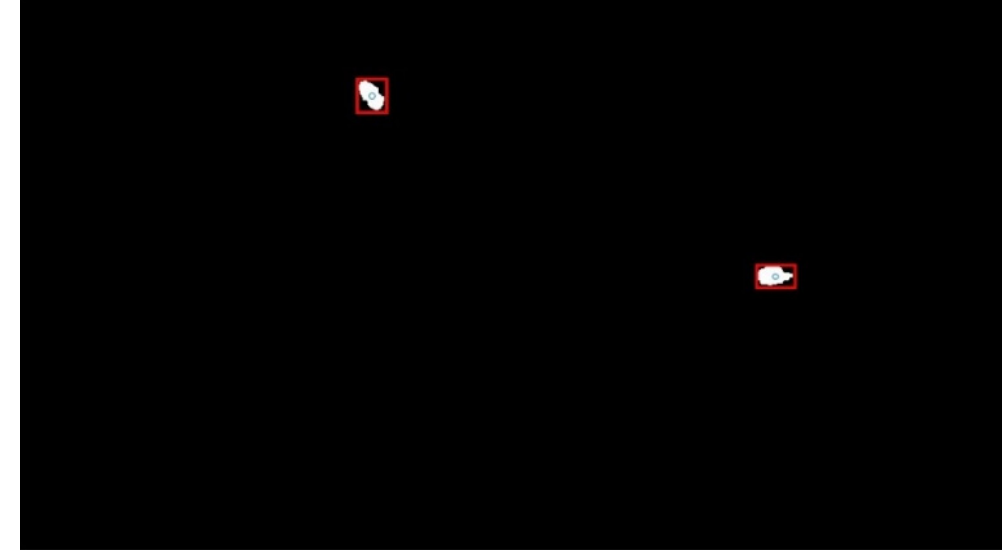
Figure 3. Sample output from digital image processing of the initial phase.